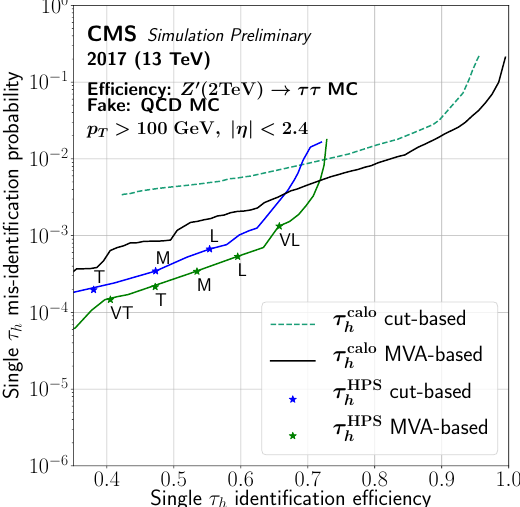
Figure 6: The ROC curves of the calo-tau and HPS-tau